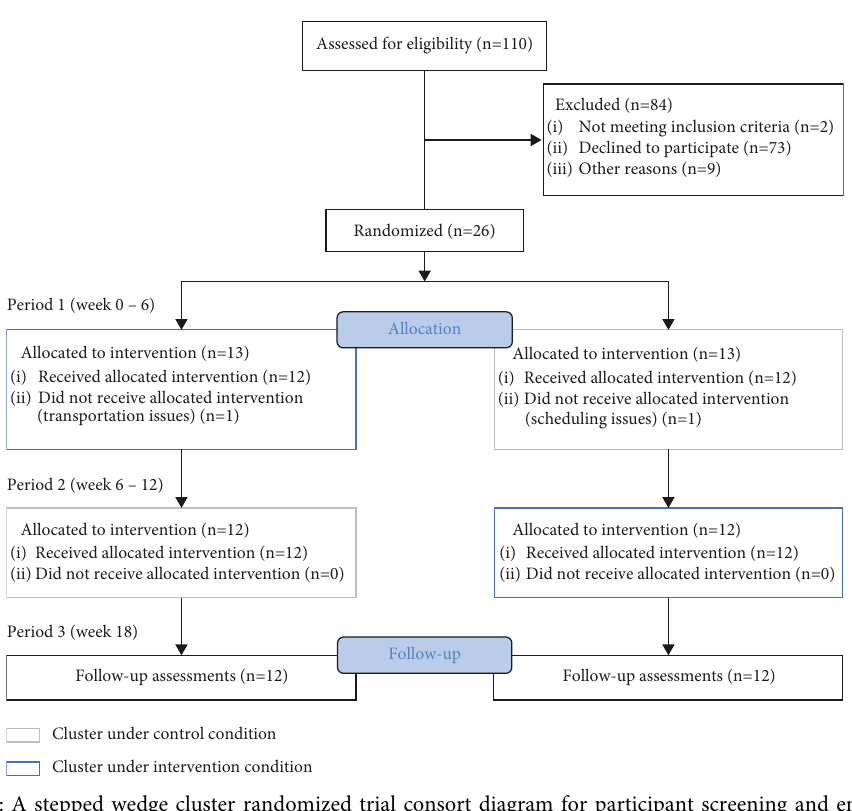
Figure 1: A stepped wedge cluster randomized trial consort diagram for participant screening and enrolment.